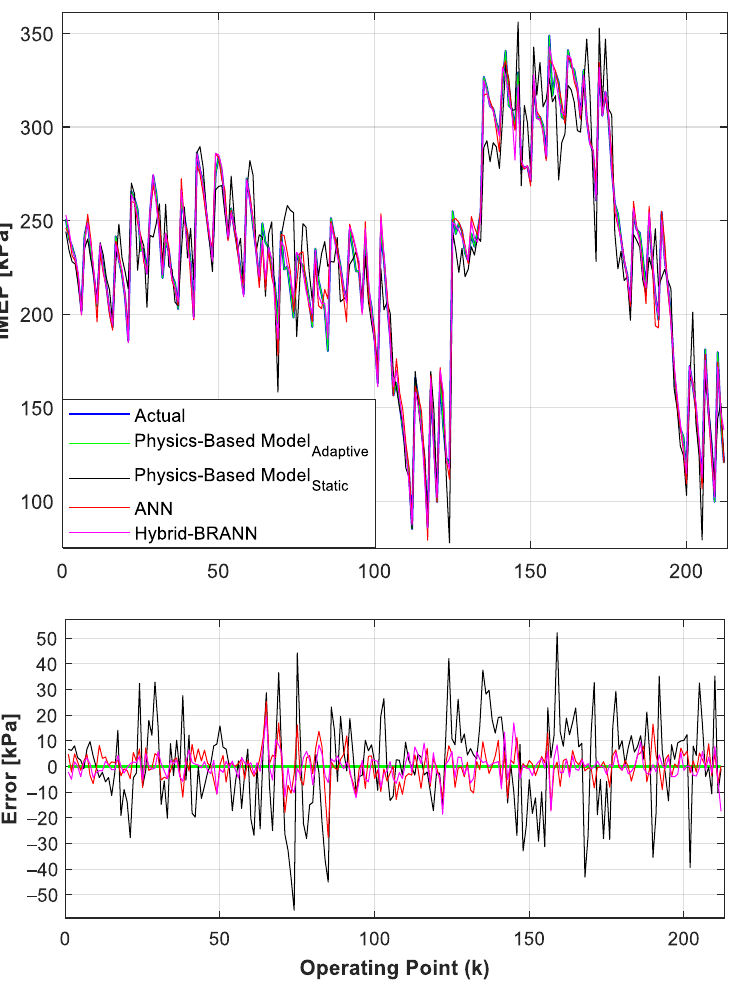
Figure 27. Comparison of actual IMEP, physics-based model predictions, classical ANN, and hy- bridized BRANN prediction.